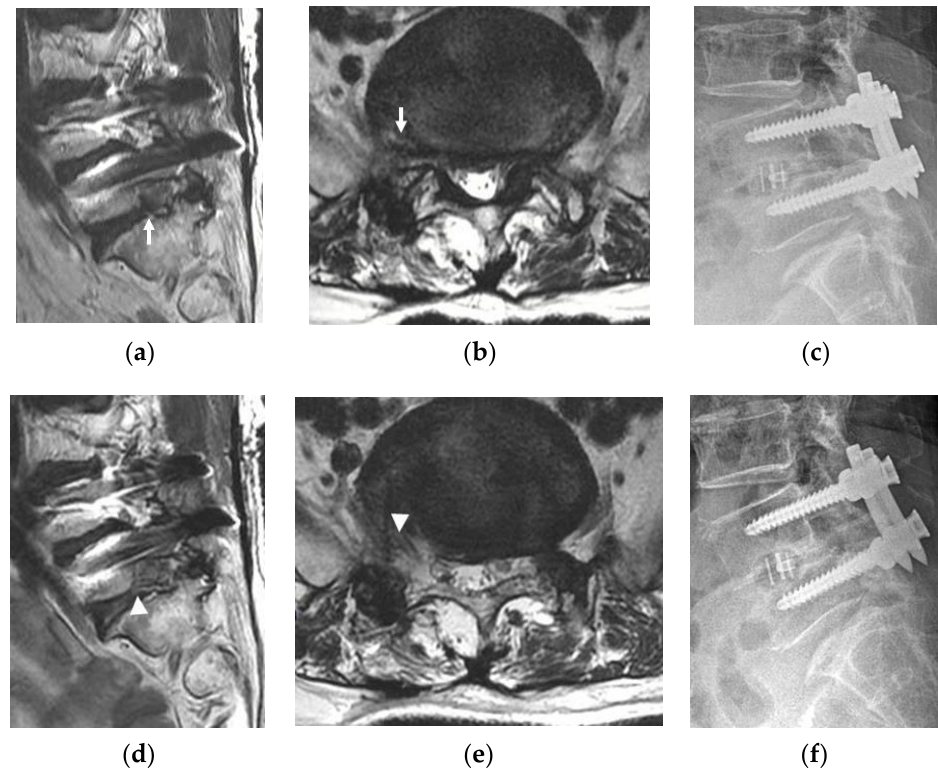
Figure 4. Case example. A 73-year-old female presented with radiating right leg pain and back pain. ( a , b ) Preoperative magnetic resonance imaging (MRI) showing lateral recess, foraminal, and extraforaminal stenosis at L5-S1 on the right (arrows). ( c ) Preoperative lateral radiograph showing previous interbody fusion at L4-L5 and a decreased L5-S1 foraminal window. ( d , e ) Adequate decompression of the lateral recess, foraminal, and extraforaminal lesions was confirmed on postoperative MRI (arrowheads). ( f ) Lateral radiograph at six months after surgery showing no definite spondylolisthesis or narrowing of the L5-S1 foramen. Transient grade 2 postoperative dysesthesia occurred.